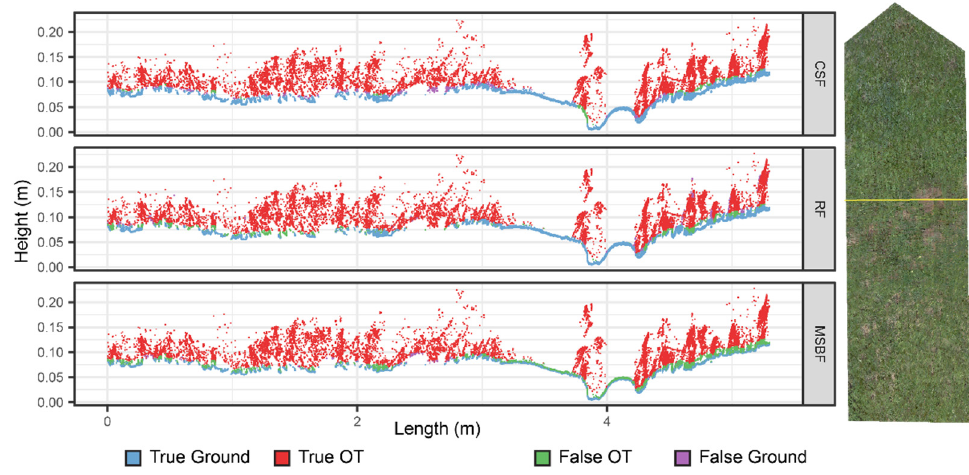
Figure 11. The classified points along a cross section profile across the middle of the plot.